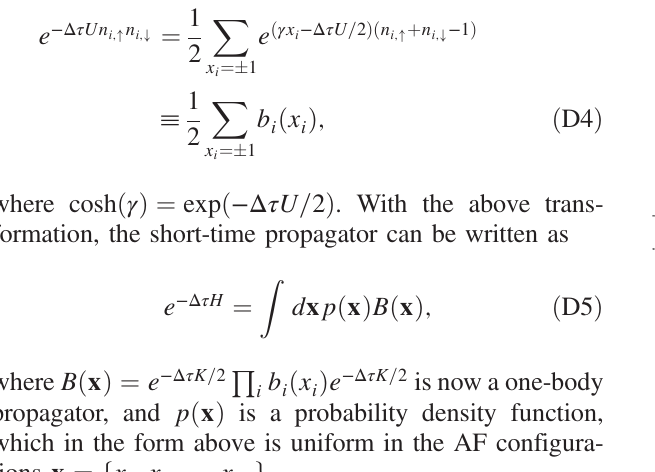
FIG. 18. Example of on-chain pair correlator in ground-state AFQMC for a 40 × 4 lattice with U ¼ − 2 t , t ⊥ ≈ 0 . 14 t , n ¼ 0 . 5 . We extract the effective order parameter for superconductivity from the square root of the long-distance behavior (dashed